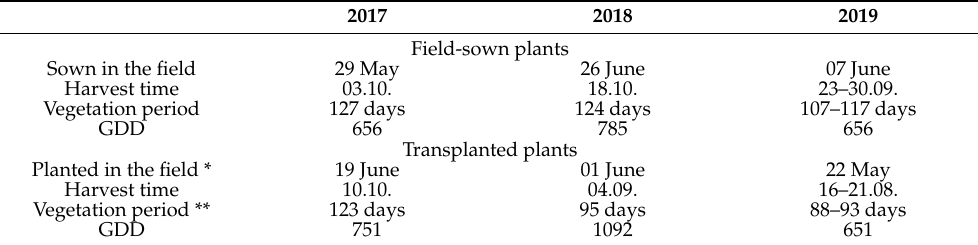
Table 1. Vegetation period parameters (sowing, planting, and harvesting dates and GDD) for vegetable soybean grown in LatHort during 2017–2019. Base temperature 10 ◦ C was used in GDD